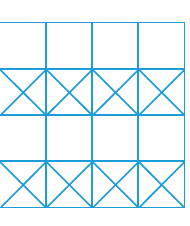
Figure 14. An example for the monitored area, which is divided into 4 × 4 grids.